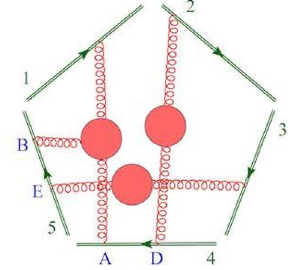
Figure 11. A sample skeleton diagram contributing to W (2 ; 1)